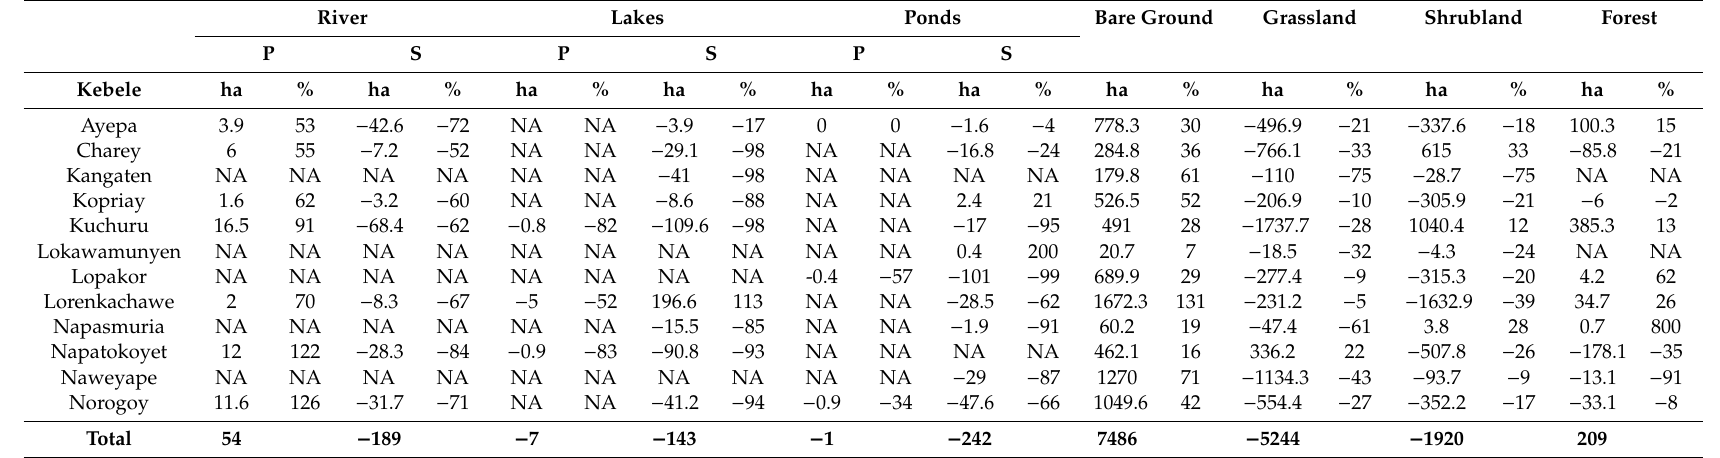
Table 5. Change in area (hectares and percentage change) of each land cover type between 2000–2003 and 2016–2019 in Nyangatom kebeles. P = permanent, S =